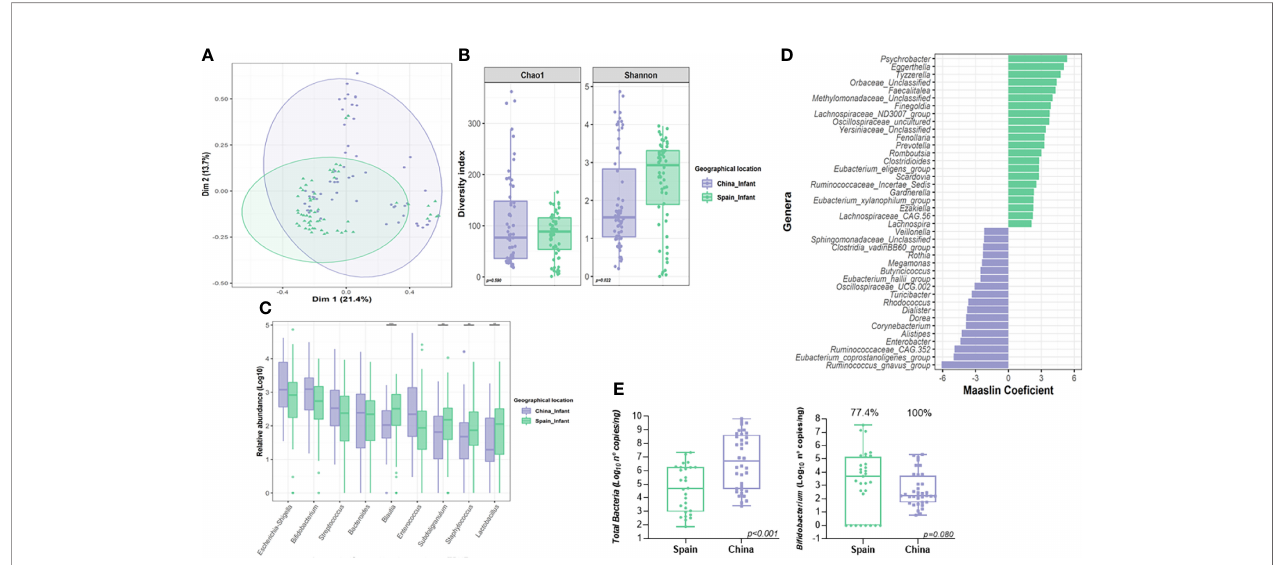
FIGURE 3 | In fl uence of geographical location on the neonatal gut microbiota. (A) Principal Co-ordinates Analysis (PCoA) analysis based on Bray-Curtis distance at genus level according to location. (B) Differences in alpha-diversity of the neonatal gut microbiota (Shannon and Chao1 index) according to location. Signi fi cance of the differences were assessed by Mann-Whitney test. (C) Comparison of core genera relative abundance between neonates from both locations. Signi fi cance was assessed by Mann-Whitney test after centered log ration transformation. Microbiota data was transformed to log10-values for plotting. (D) Results from the multivariate Maaslin2 analysis showing the differences in terms of microbial composition according to location adjusted by maternal, body mass index and delivery mode. Only those genera that appeared more than 3 times in at least 10% of samples were included in the analysis. To facilitate the visualization, only those genera with a coef fi cient higher than 2 was plotted (complete list in Table S3 ). (E) Comparison of the quantitative analysis of total bacterial and Bi fi dobacterium counts expressed as